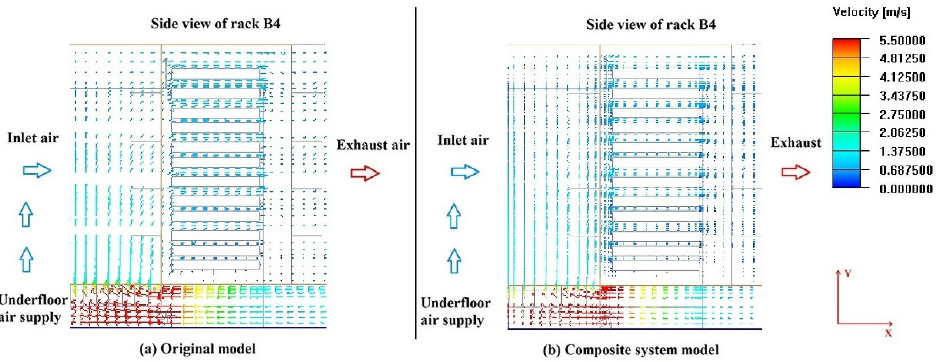
Figure 10. The air flow pattern of the rack B4 in the original model and composite cooling model (installation height 0.01 m).